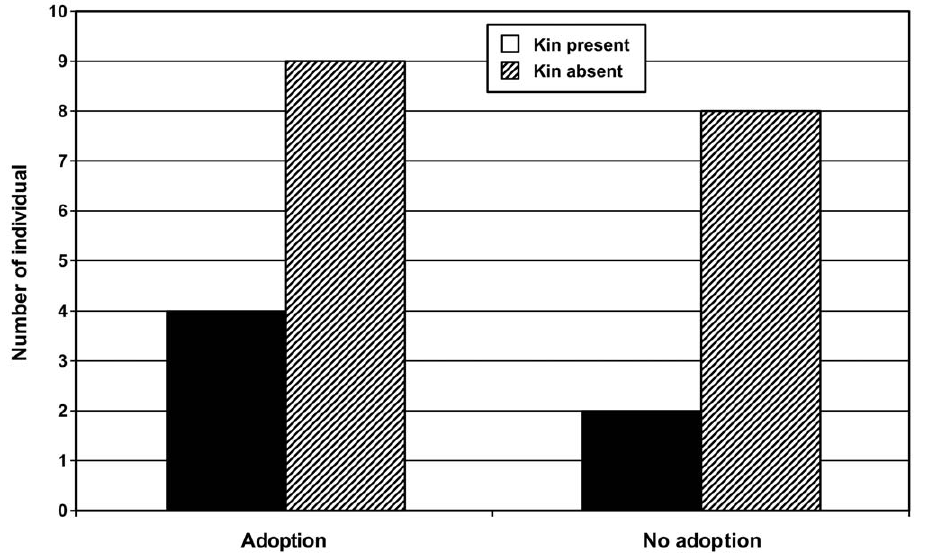
Figure 1. The presence of a close kin does not increase the likelihood of adoption in Taı¨ chimpanzees (Fisher exact test: p=0.463).